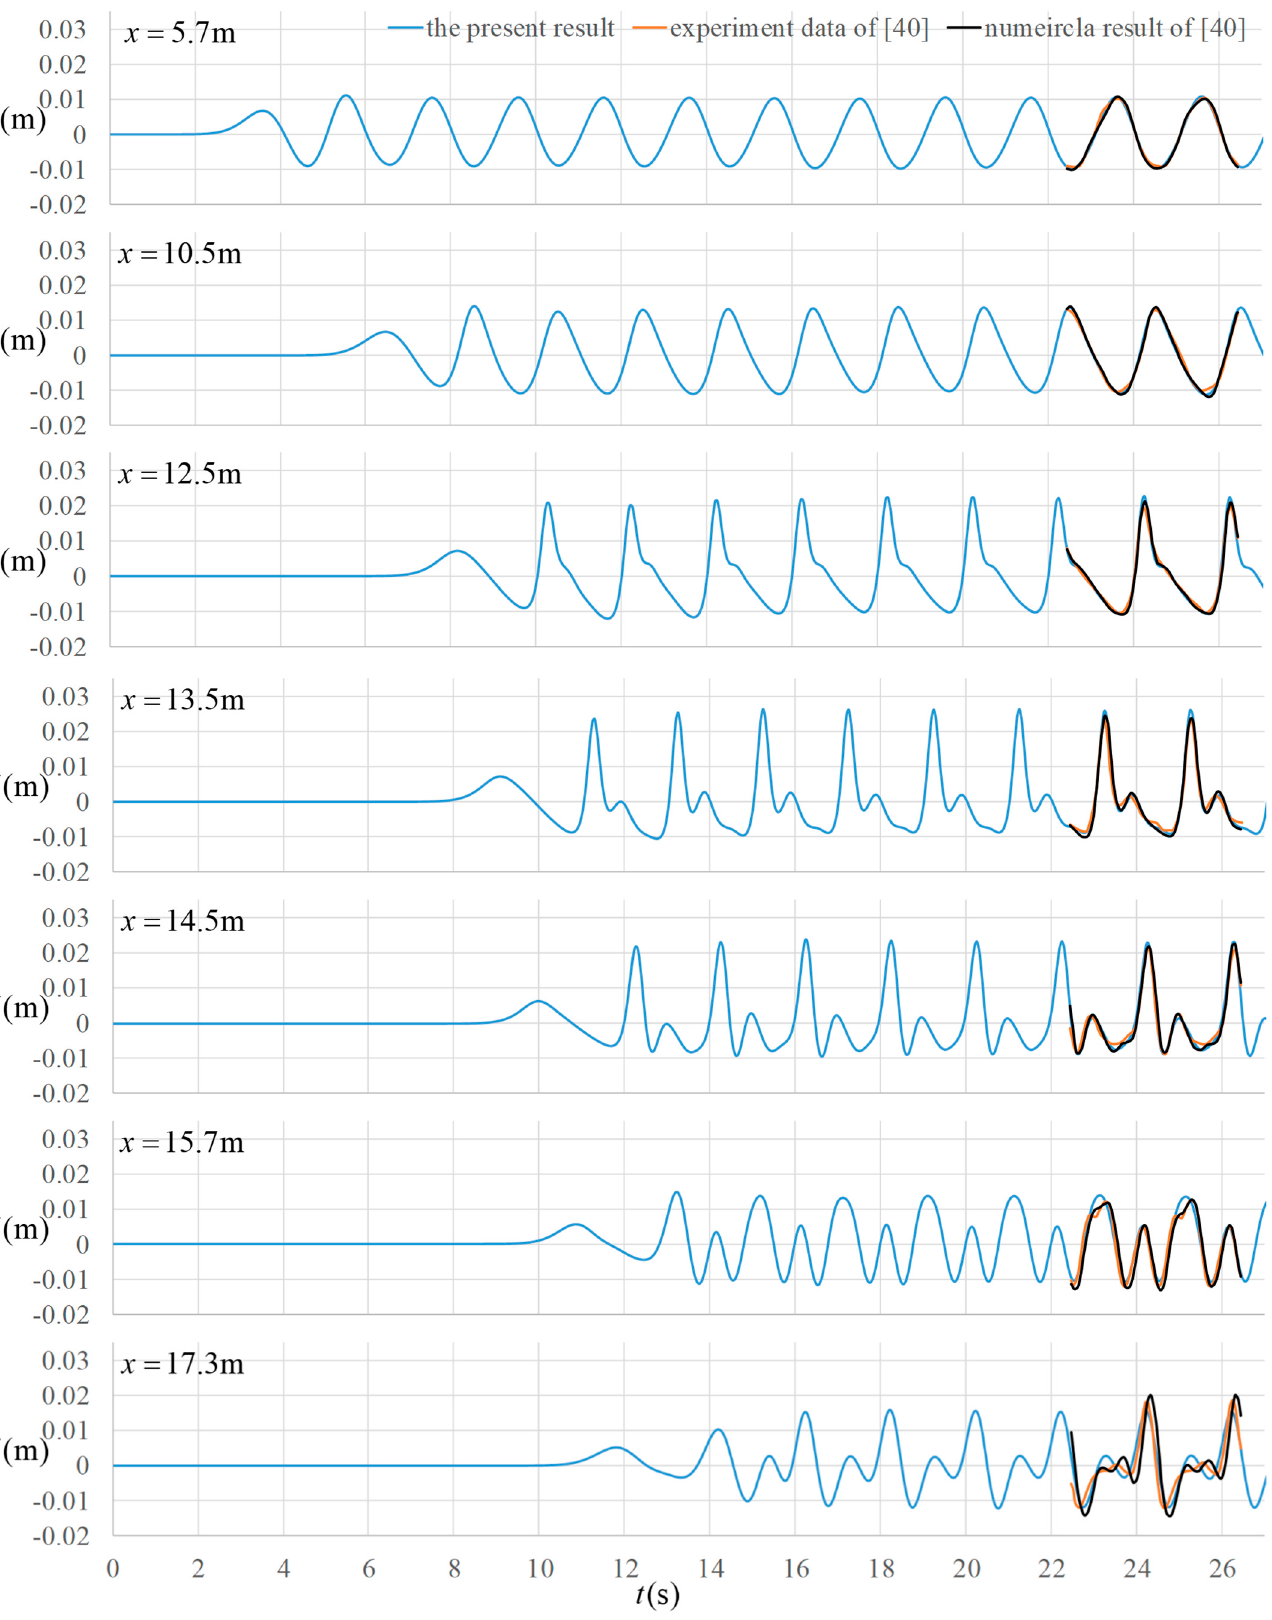
Figure 10. Comparison of the present numerical results with other data (numerical result of [40] and experiment data of [40]) at wave gauges for the case of nonlinear waves generated by a large stroke harmonic motion of a piston type wave maker.